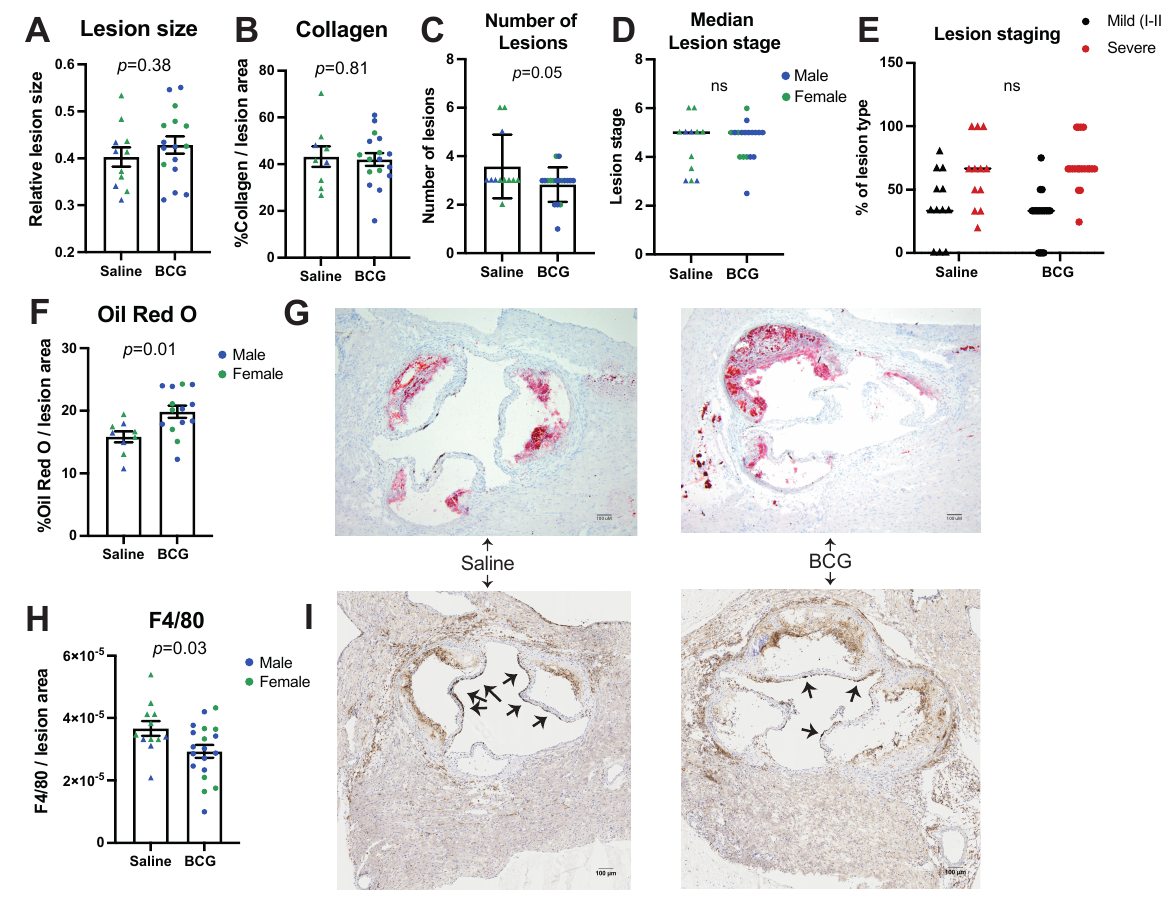
Figure 2. Analysis of atherosclerosis severity in aortic sinus of ApoE − / − mice. Atherosclerosis was assessed using several measures: ( A ) Atherosclerotic lesion size, ( B ) Collagen content and ( C ) Number of lesions as well as ( D ) median lesion stage between groups and ( E ) % type of lesion stage for each plaque (mild (black) or severe (red)); n = 11 for Saline (depicted as triangles) and n = 16 for BCG (depicted as circles). The number of lesions was significantly decreased in BCG-treated mice, whereas the median lesion stage was similar between groups. In ( A – D , F , H ); males are depicted in blue, females in green. ( F ) Aortic Sinus plaque lipid content was measured by Oil Red O staining and was increased in BCG-treated mice; n = 8 for Saline, n = 12 for BCG. ( G ) Representative Oil Red O images of the aortic sinus, from Saline and BCG treated mice. ( H ) F4/80 macrophage staining of plaques was significantly decreased in BCG-treated mice; n = 12 for Saline and n = 19 for BCG. ( I ) Representative images of F4/80 staining (some staining indicated by